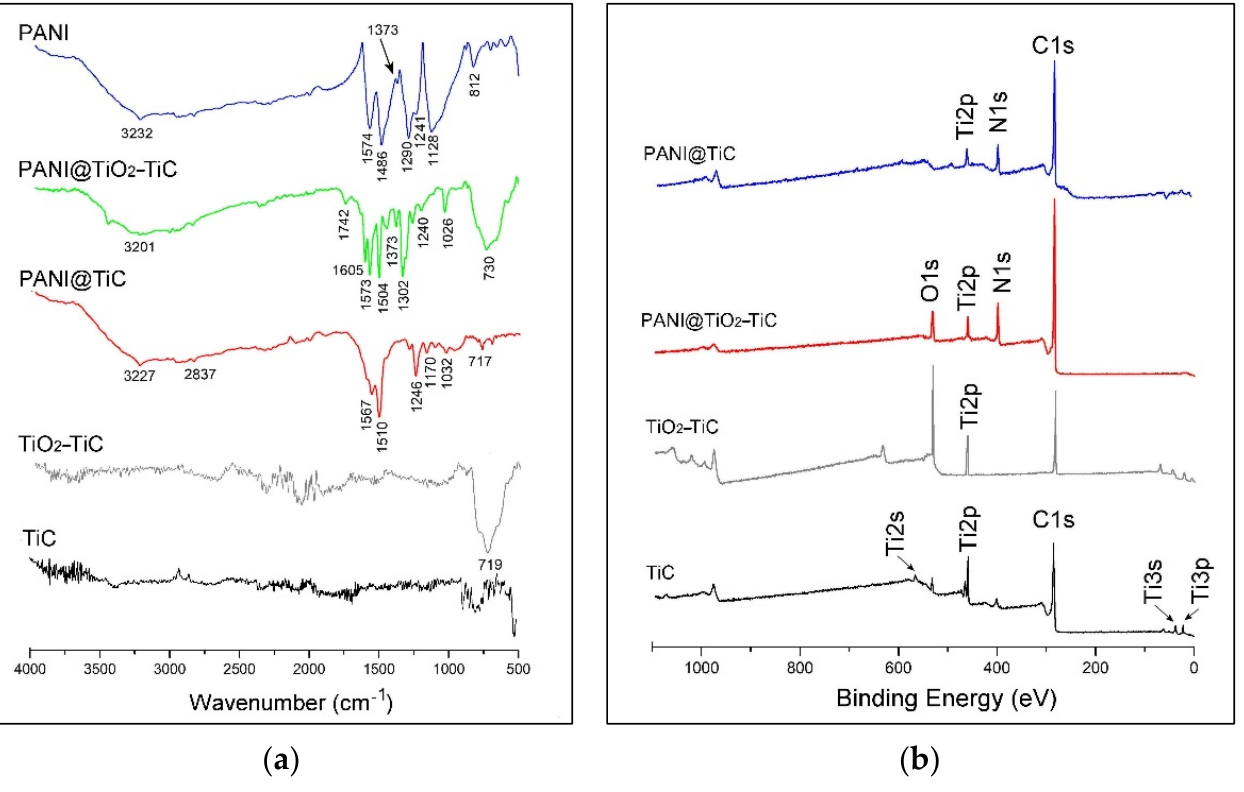
Figure 1. ( a ) FTIR analysis; and ( b ) survey XPS spectra of samples.